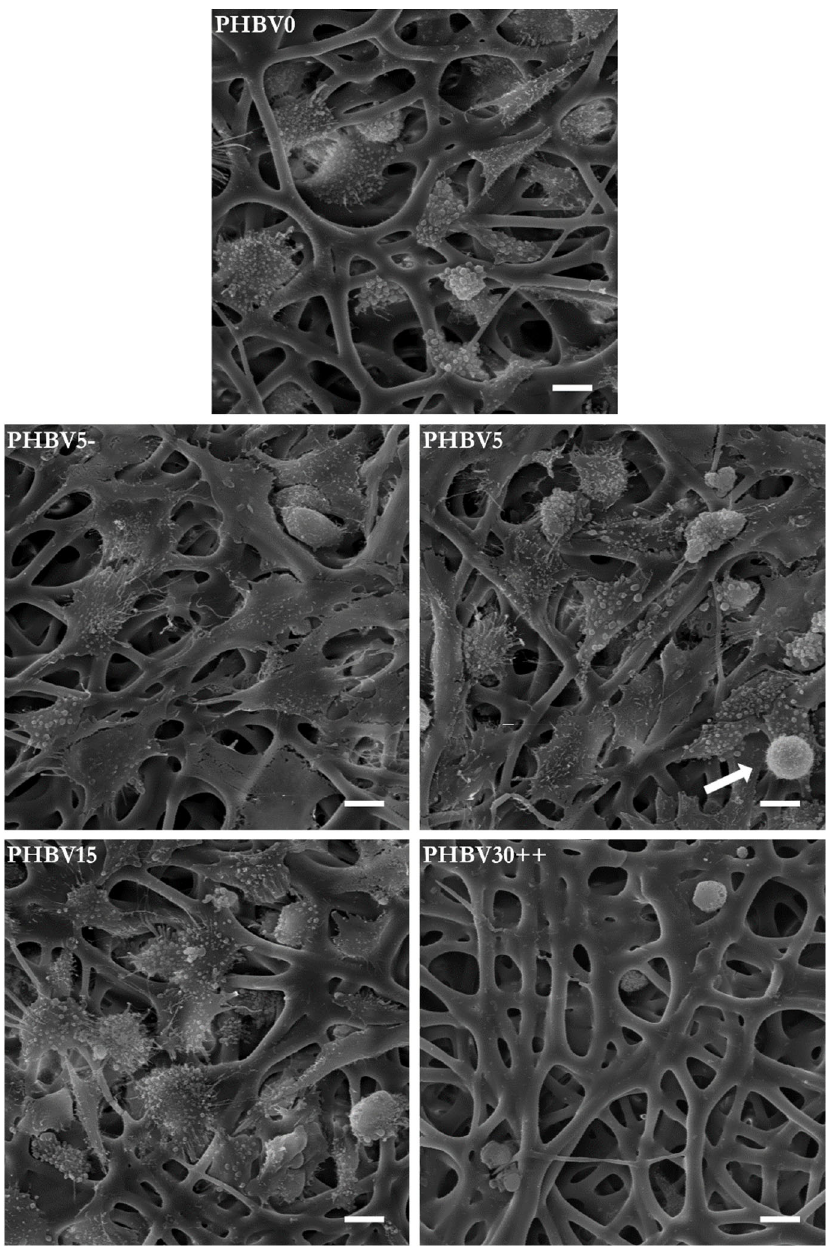
Figure 9. SEM images of SaOS-2 cells cultured for 7 days on the PHBV fibers modified under different reaction conditions (scale bars are all 10 μ m). The white arrow on the image of the PHBV5 mat indicates the cell with mitotic morphology.